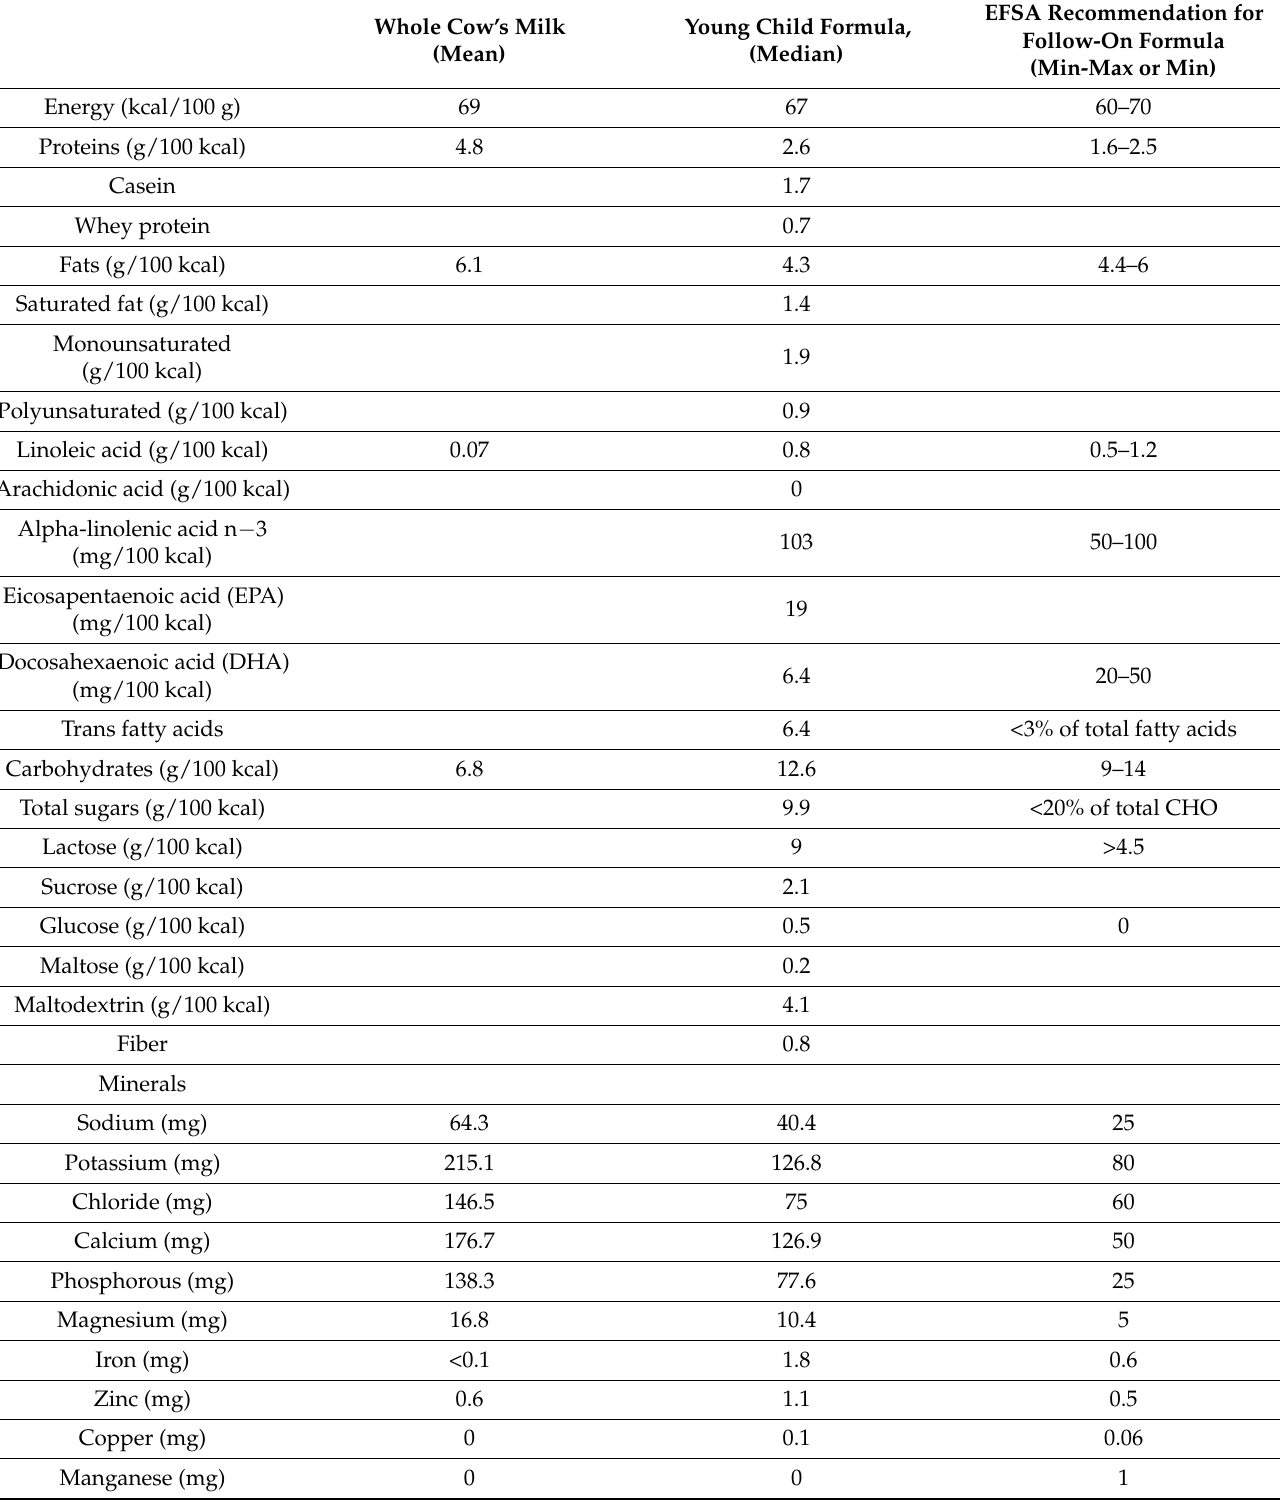
Table 3 show the composition of whole cow’s milk, young child formula, and follow-on formula. Table 3. Nutrient composition of cow’s milk and young infant formula on average compared to EFSA recommendation for follow-on formulae 1